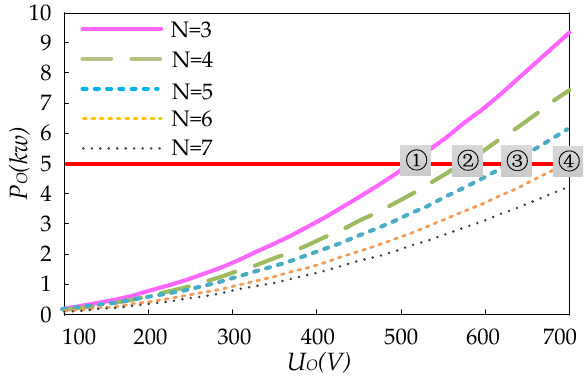
Figure 4. Receiving power per EV versus source voltage when the number of EV varies from 3–7.